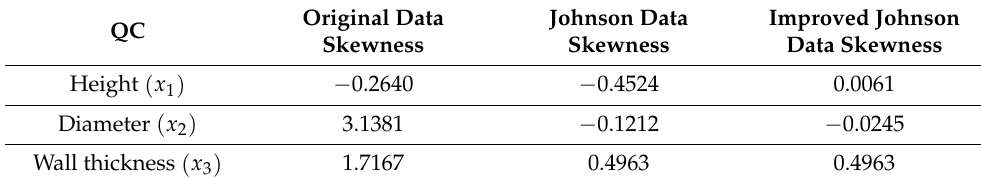
Table 8. Correlation matrix.